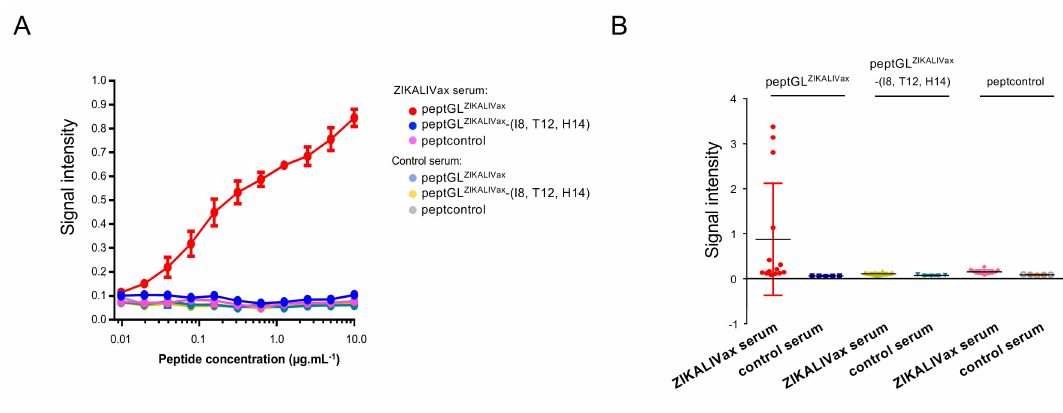
Figure 2. Immunoreactivity of pept GLZIKALIVax . The O.D 450 or signal intensity of samples in dose-response curves of peptGL ZIKALIVax and mutant peptide peptGL ZIKALIVax -(I8, T12, H14) in relation to anti-ZIKALIVax immune serum (ZIKALIVax serum) at dilution 1:200 measured through peptide-based ELISA. Serum of mice that received heat-inactivated ZIKALIVax at dilution 1:200 served as a control serum. Peptcontrol peptide was used as a negative peptide control. In ( A ), plates were coated with increasing concentrations of peptides and incubated with a pooled ZIKALIVax immune serum. In ( B ), peptides at concentration of 3 µ g mL − 1 were incubated with 14 individual anti-ZIKALIVax immune